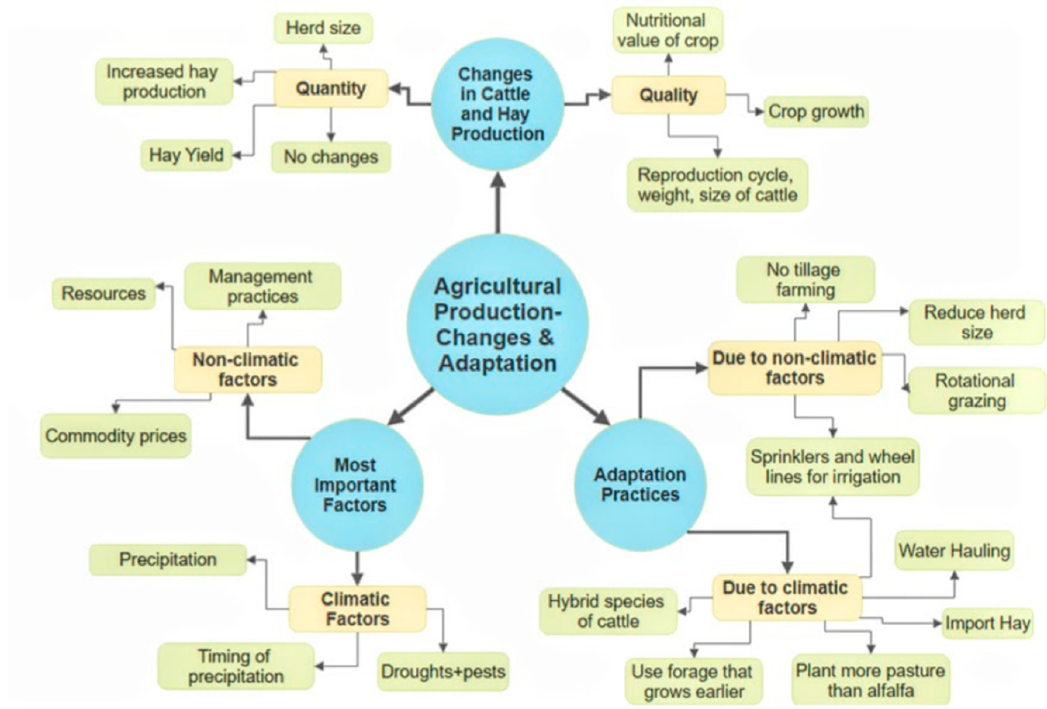
Figure 9. Thematic network for the interview results with the farmers/ranchers in Upper Colorado River Basin in Utah.